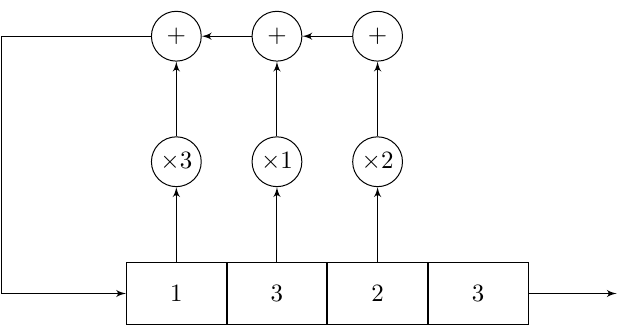
Figure 5: A minimal length LFSR generating the finite sequence (3 , 2 , 3 , 1 , 3 , 2 , 4) over Z 7 . Note that the coefficients of the connection polynomial are the negation of the multiplicands in this diagram. This LFSR has length 4, yet the minimal polynomial is of degree